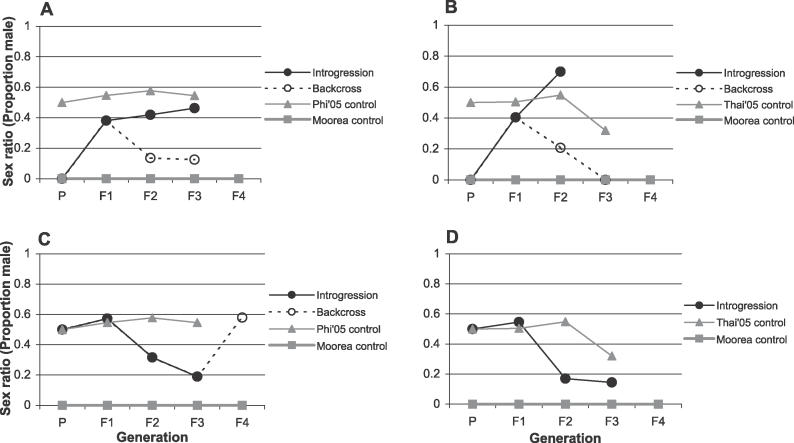
Sex Ratio Produced by wBol1-Infected Females during Introgression onto Different Host Genetic Backgrounds(A) The mean sex ratio (proportion male) produced by wBol1 infected H. bolina derived from the Moorean matriline 595 on introgression onto a Phi ‘05 nuclear background over three generations. Solid black: introgression onto a Phi ‘05 nuclear background; dashed black: backcross to Moorean males; grey triangles: Phi ‘05 control; grey squares: Moorean matriline 595 control.(B) As above, for the Moorean 787 wBol1 isolate introgressed onto a Thai '05 nuclear background. Solid black: introgression; dashed black: backcross to Moorean males; grey triangles: Thai ‘05 control; grey squares: Moorean matriline 787 control.(C) The sex ratio (proportion male) produced by wBol1 infected H. bolina derived from the Philippines (Phi '05) on introgression onto a Moorean nuclear background over 3 generations. Solid black: introgression; dashed black: backcross to Moorean males; grey triangles: Phi ‘05 control; grey squares: Moorean control.(D) As above, for the Thai ‘05 infection introgressed onto a Moorean nuclear background. Solid black: introgression; grey triangles: Thai '05 control; grey squares: Moorean control.Samples sizes and number of crosses performed are given in text and in Tables 1 and 2.